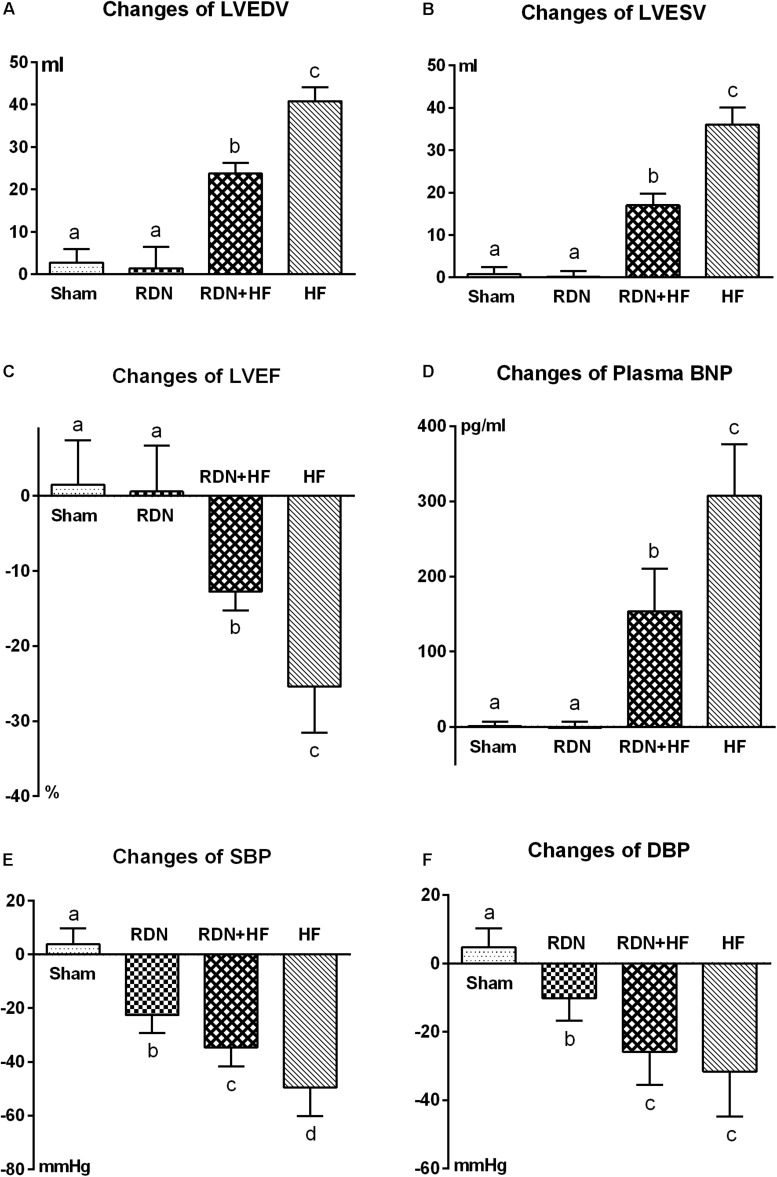
Comparative analyses of echocardiographic measurements (A–C), plasma BNP (D), and BP (E,F) among the different study groups after interventions. LVEDV, left ventricular end-diastolic volume; LVESV, left ventricular end-systolic volume; LVEF, left ventricular ejection fraction; BNP, brain natriuretic peptide; BP, blood pressure. The different lowercase letters show significant differences in changes of specific parameter among groups (p < 0.05), whereas the same lowercase letters indicate no statistical differences (p > 0.05).